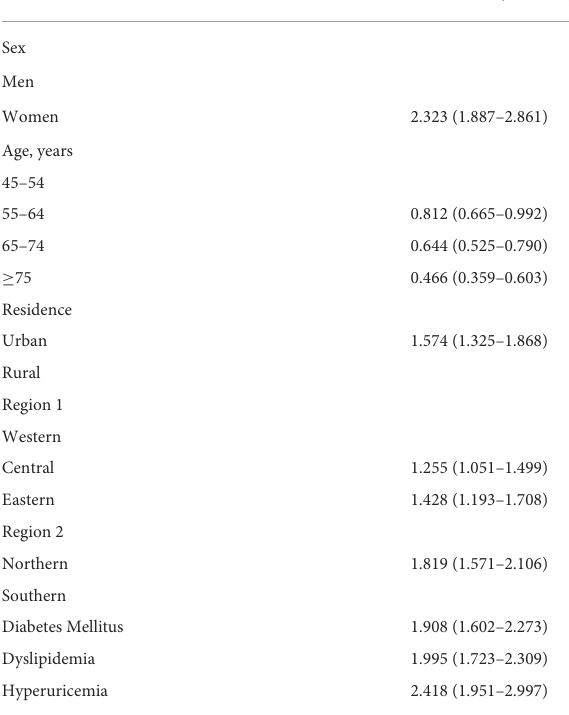
Valuesarepresentedasn(%). TABLE 7 Multivariable-adjusted odds ratios for the obesity-related